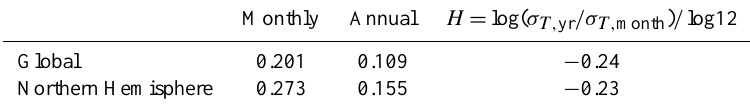
Table 3. The various standard deviations of the temperature residues ( T nat ) after removing T anth at monthly and annual resolution and the estimate of H obtained assuming perfect scaling over a factor of 12 in timescale (units: K).